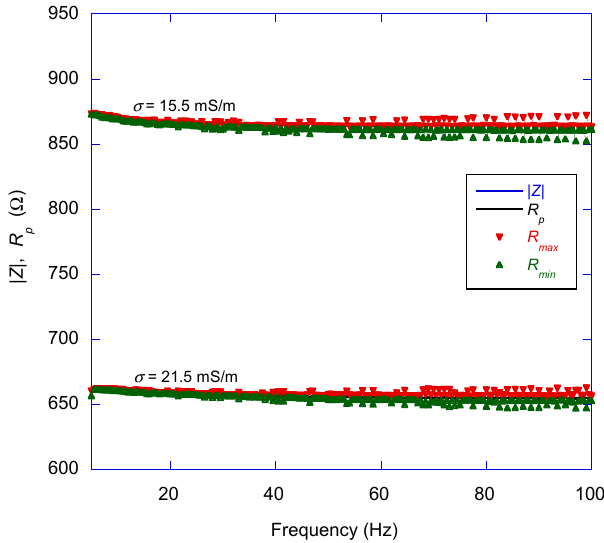
Figure 3. Apparent impedance and resistance of water as a function of frequency.